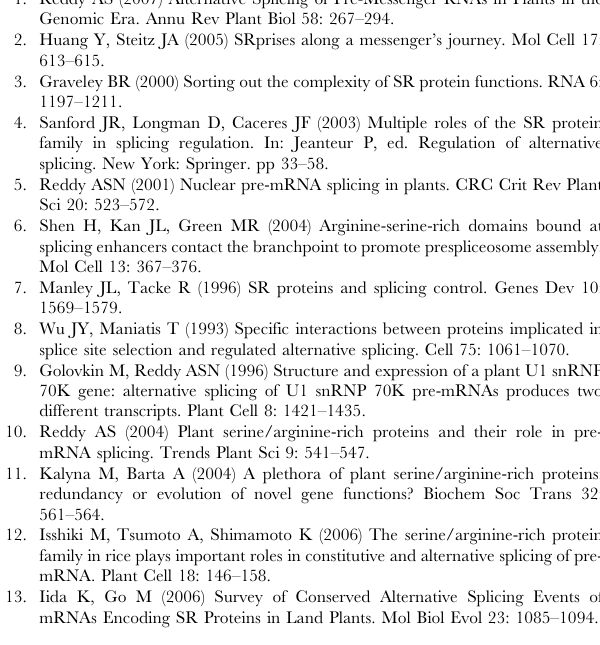
Figure S2 Expression analyses of leaf shape and floral organ number genes in WT and sr45-1 plants. (A) RT-PCR was performed with total RNA isolated from two week old plants with gene-specific primers as described in the Experimental procedures.